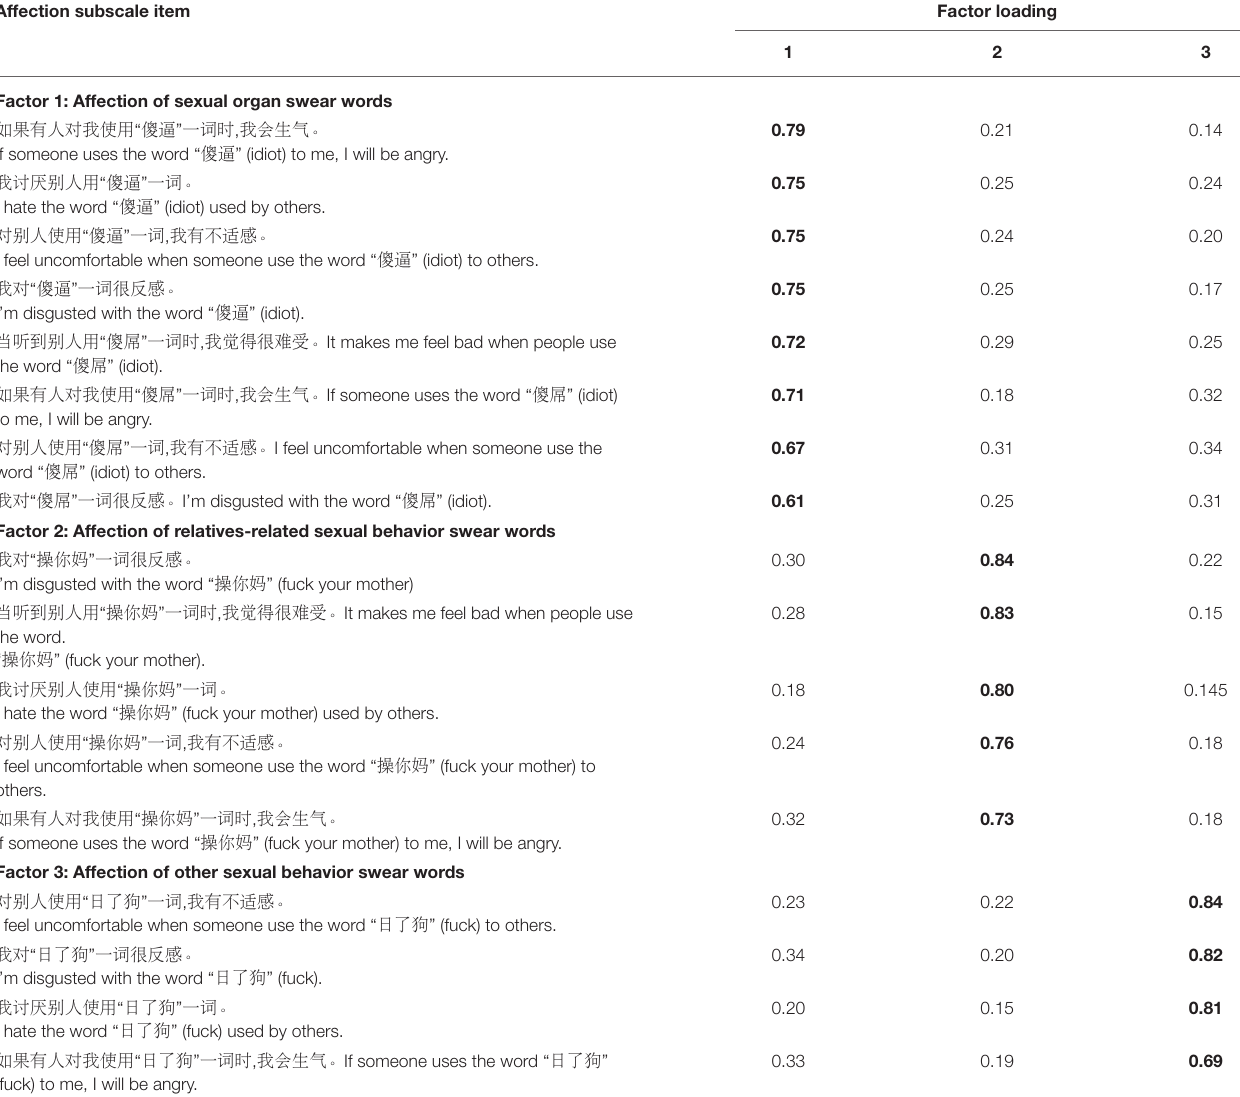
TABLE 3 | Exploratory factor analysis results of Affection subscale. Affection subscale item Factor